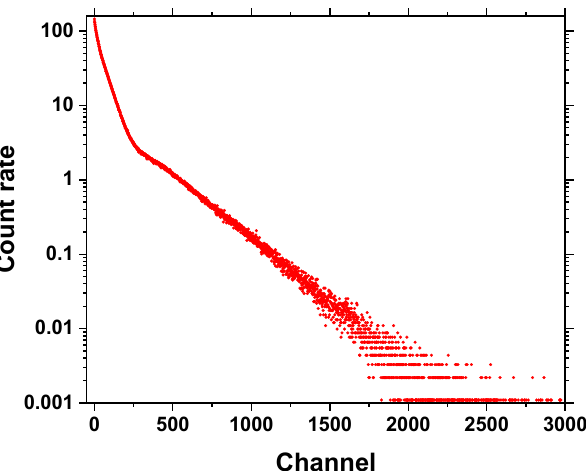
Figure 4. Part of the typical spectrum from the plastic scintillator (0:3000 channel). A few events were found in the channels ranging from 3001 to 8192.